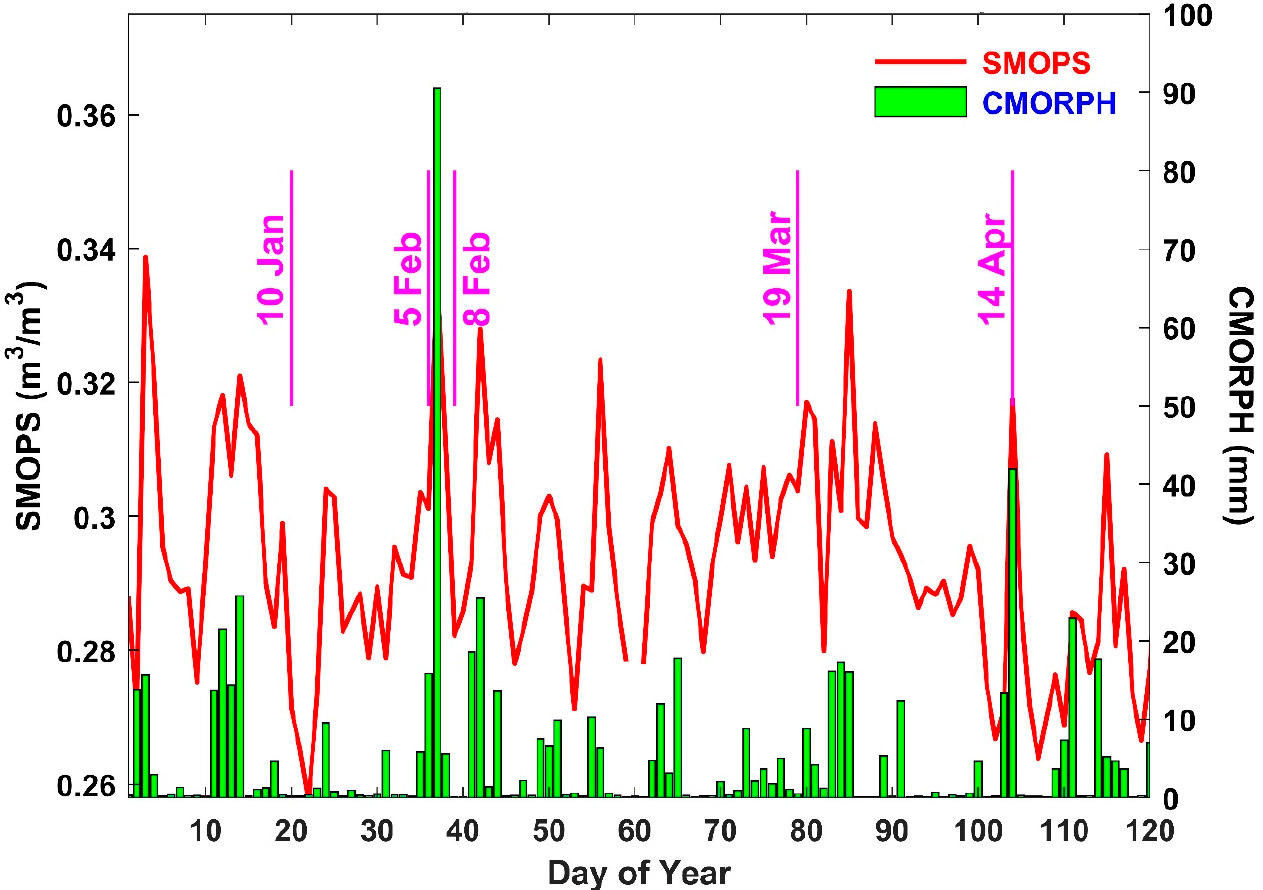
Figure 10. Average of daily SMOPS and CMORPH over the 1 January (day 1)–29 April 2020 (day 120) period for the domain extending from 34.25°N, 85.00°W to 37.25°N, 80.00°W.